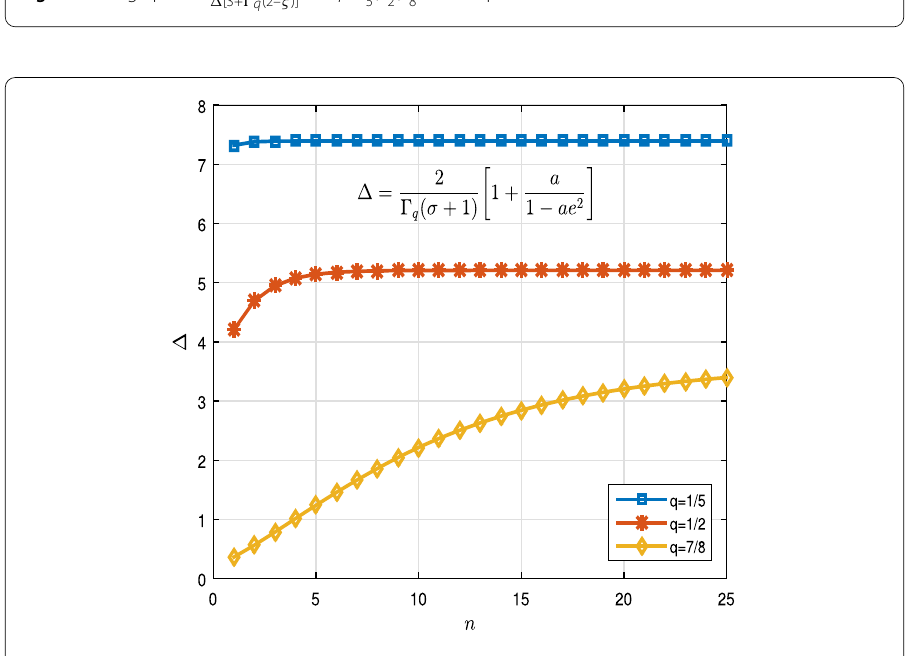
, 1 , 7 in Example 4.3 5 2 8